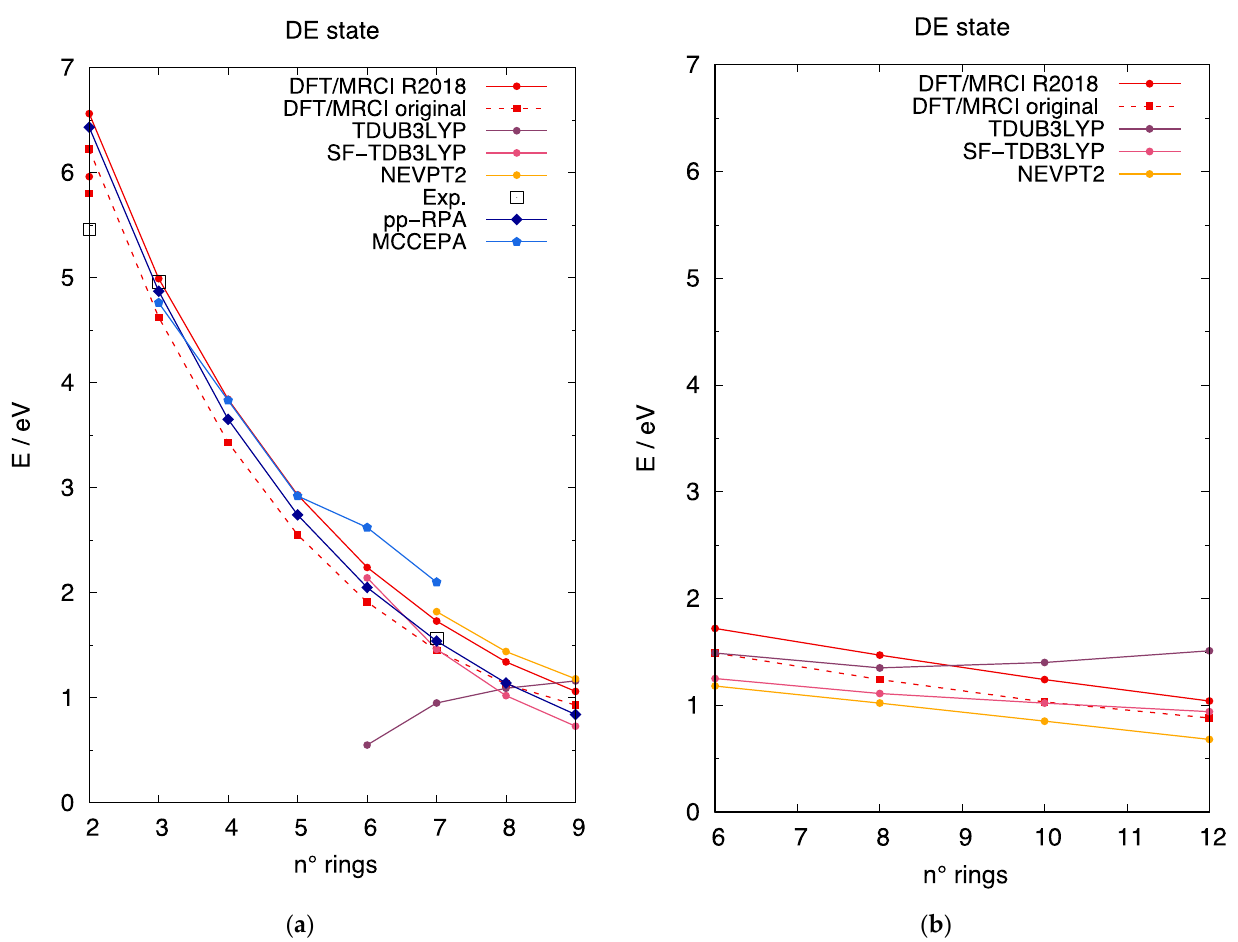
Figure 6. The excitation energy to the DE state (i.e., the state dominated by the HOMO, HOMO → LUMO, LUMO excitation) described at different computational approaches. The excitation energy scale is the same in the two panels to allow a direct comparison between linear and cyclic acenes. ( a ) Excitation energy of the DE state for [n]-acenes as a function of the number of rings: (red circles) DFT/MRCI R2018 parametrization; (red squares, dashed line) DFT/MRCI original parametrization; (pink circles) TDB3LYP; (purple circles) TDUB3LYP; (dark-rose circles) SF-TDB3LYP; (gold circles) NEVPT2; (black empty squares) experimental from refs. [16,92,93]; (blue diamonds) pp-RPA from ref. [30]; (royal-blue pentagons) MCCEPA from ref. [18]. ( b ) Excitation energy of the DE state for [ n]-CCs as a function of the number of rings: (red circles) DFT/MRCI R2018 parametrization; (red squares, dashed line) DFT/MRCI original parametrization; (pink circles) TDB3LYP; (purple circles) TDUB3LYP; (dark-rose circles) SF-TDB3LYP; (gold circles) NEVPT2.